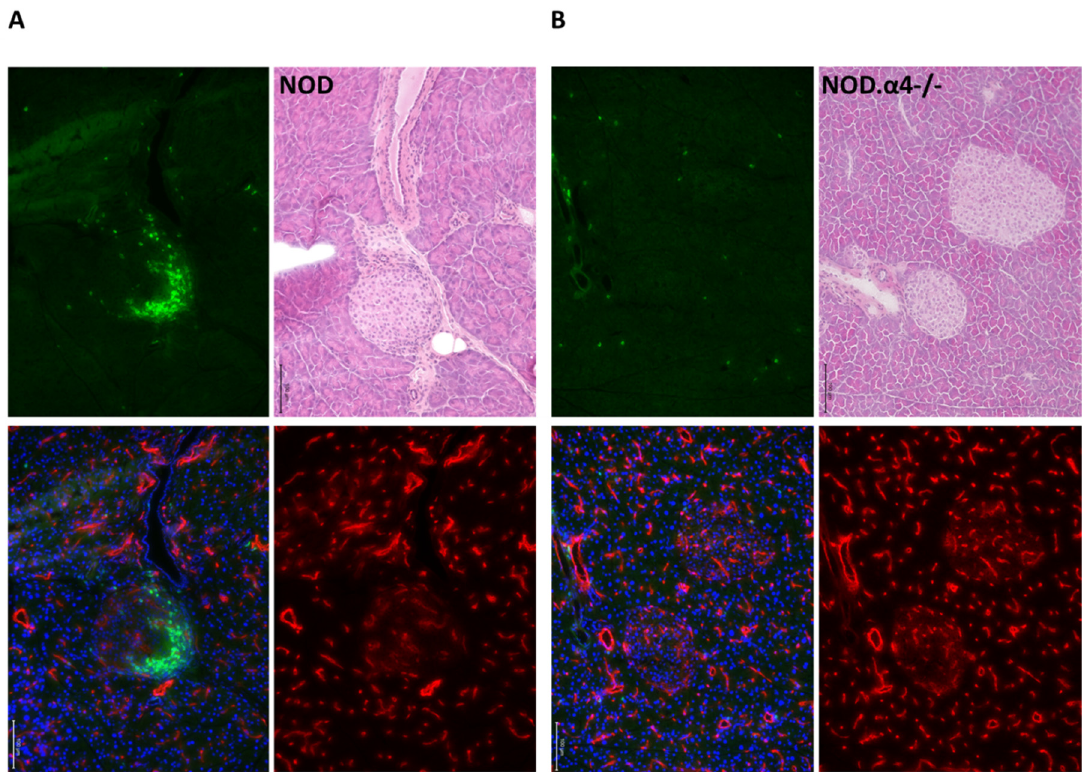
Figure 3. Pancreas immunofluorescence histology of young adult non-diabetic mice. Pancreas from NOD ( A ) and NOD. α 4- / - ( B ) young adults is shown, with a prominent lymphocyte infiltrate in ( A ). Adjacent sections were used for hematoxylin–eosin (HE) or immunohistochemistry staining (CD3: green, Meca32: red, merged fluorescence image including DAPI; 20 × original magnification; 100 µ m size bars in image).